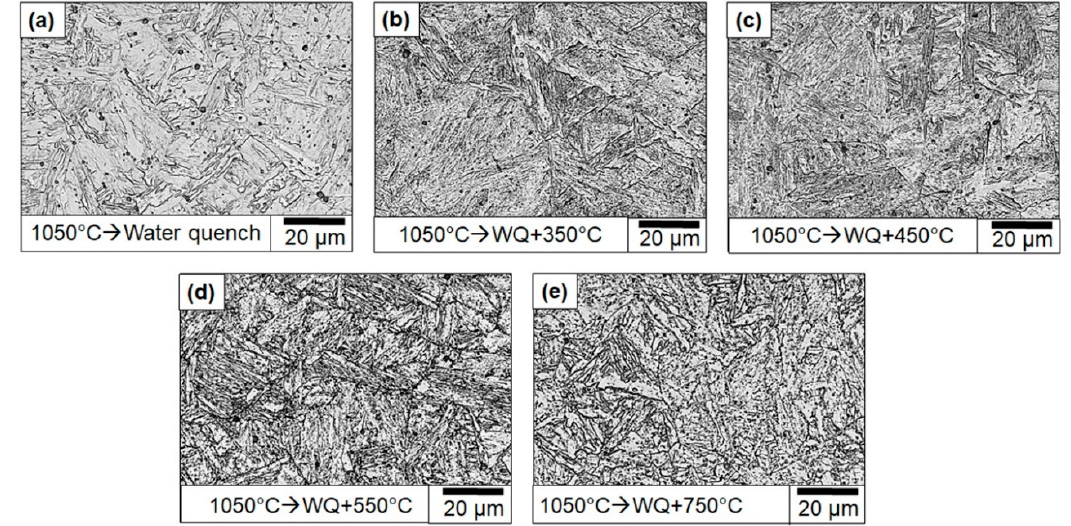
Figure 12. Optical micrographs of ( a ) austenitized followed by water-quenched and tempered samples with tempering temperature; ( b ) 350°C; ( c ) 450°C; ( d ) 550°C; ( e ) 750°C.